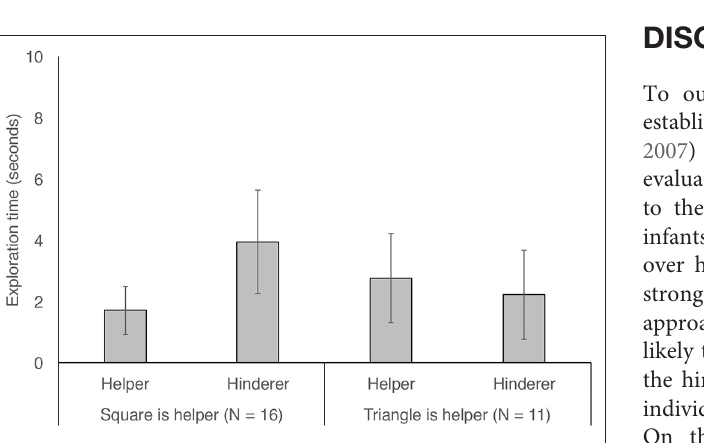
FIGURE 2 | Figures showing proportion of dogs who chose to first approach the helper vs. the hinderer (left) and probability that dogs engaged with handlers during Helper and Hinderer events (right) . Dotted line shows expectation of chance-level behavior and error bars show 95% confidence intervals.